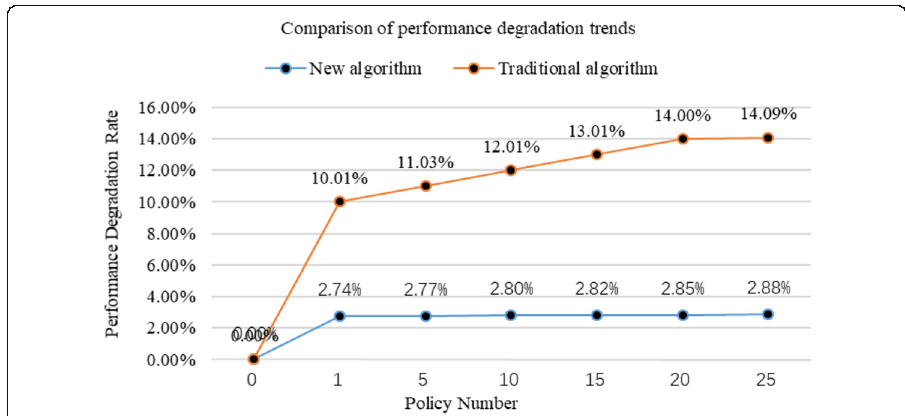
Fig. 8 Comparison of performance degradation